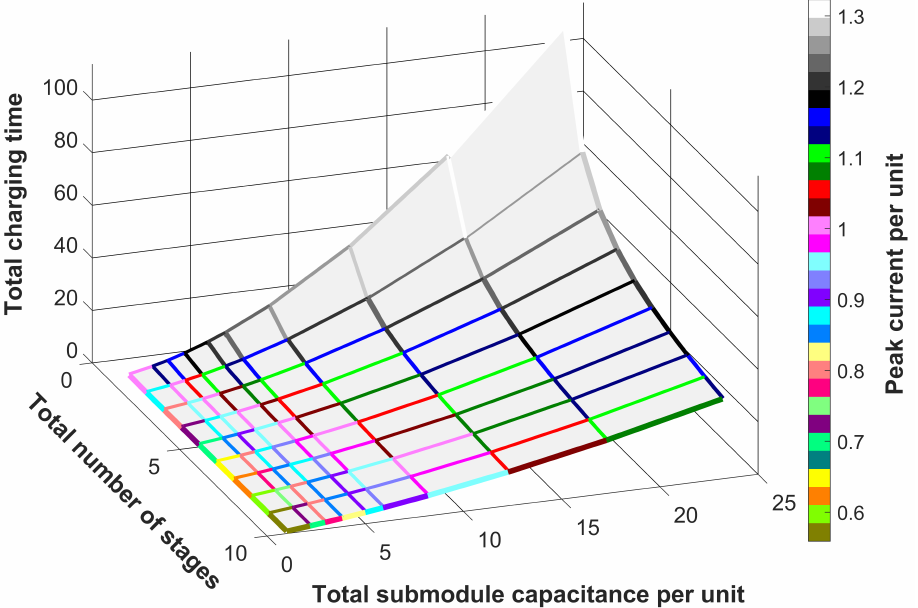
Figure 3. The 4D plot of the total submodule’s capacitance, the total number of stages, the resulting peak current, and the total charging time “ T Start - up